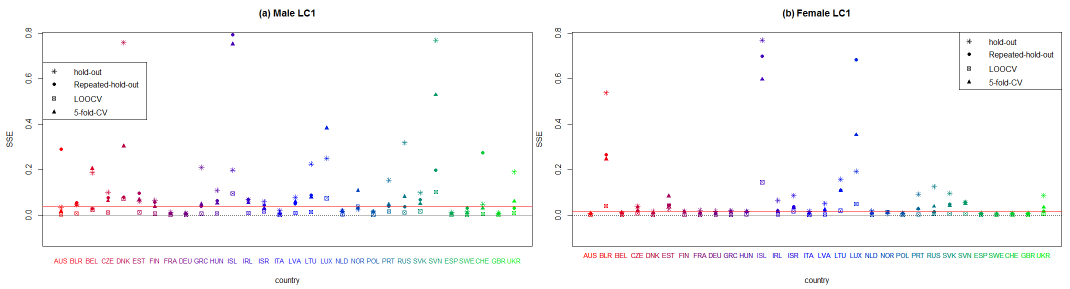
Figure A1. Plot summarizing the sum of squares errors (SSE) of each European country that applies the unifactorial Lee–Carter model to males and females, according to every employed resampling